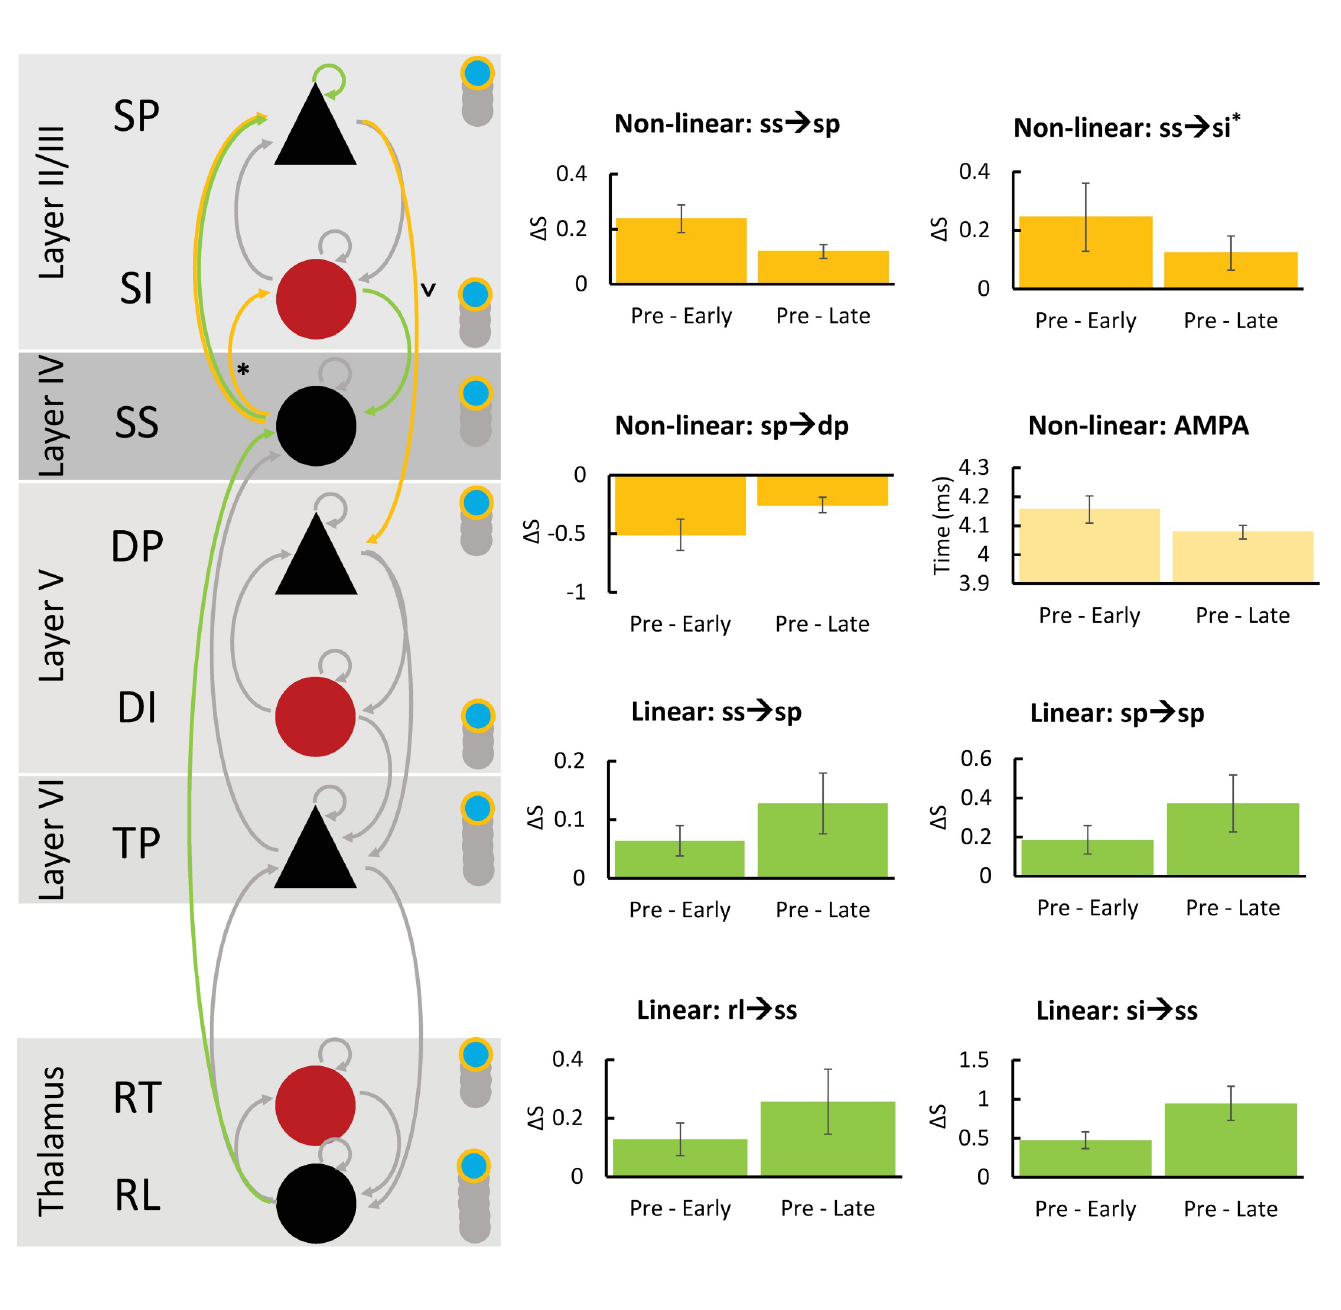
Fig 6. The RM-MANOVA on the task-specific effects for both the non-linear (yellow) and linear (green) models demonstrated that the connectivity between spiny stellates (ss) and superficial pyramidal cells (sp) were greater than pre-tetanus in both the early and late post-tetanus conditions. Non-linear task-specific effects included significant changes in ss to superficial inhibitory interneuron (si) connectivity ( � indicates uncorrected), and sp to deep pyramidal (dp) connectivity. For sp to dp this was a decrease in connectivity (connection indicated by a ˅ ). The AMPA decay constant was significantly longer than pre-tetanus for both conditions post-tetanus, but degraded by late post-tetanus. For linear effects, the self-gain of sp was significant, as was si to ss. Thalamic relay (rl) to ss was also